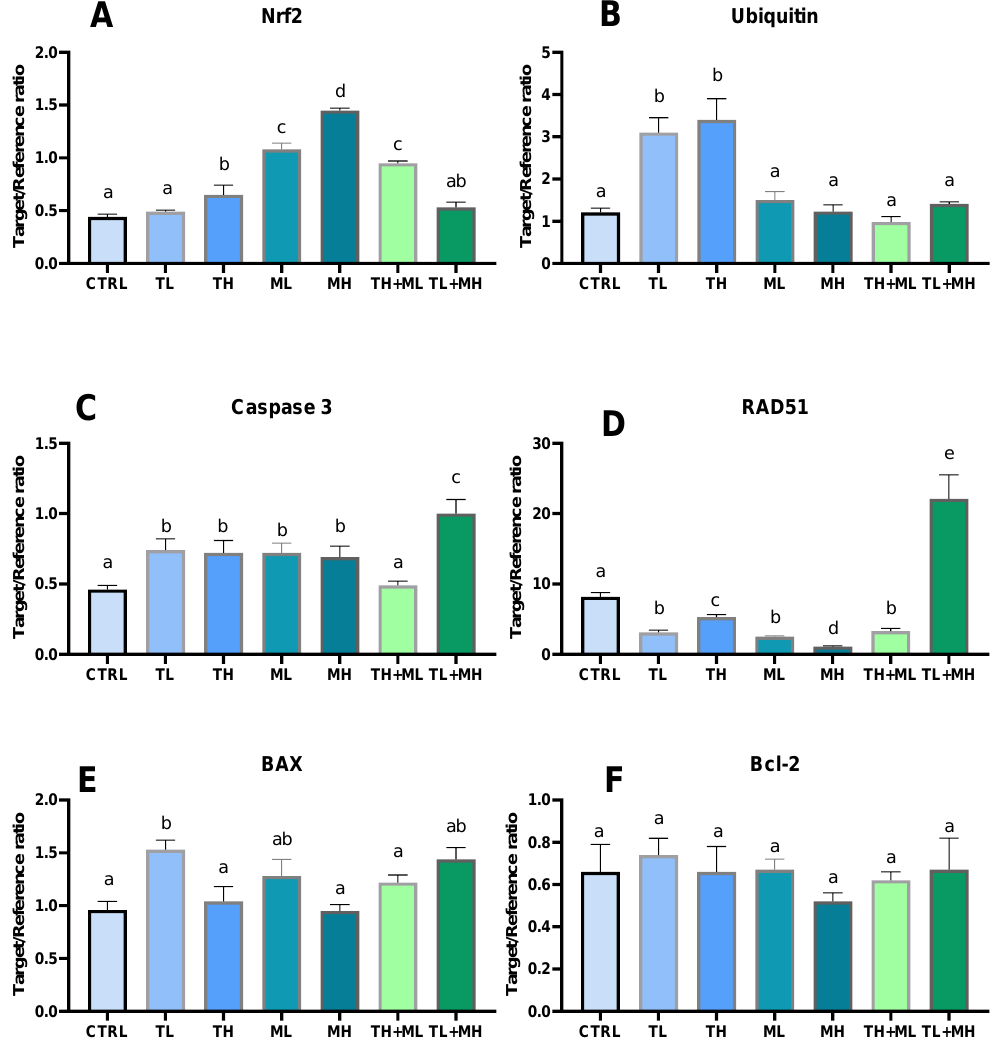
Figure 5. Effects of terbuthylazine (2 µ g L − 1 (TL) and 30 µ g L − 1 (TH)) and malathion (5 µ g L − 1 (ML) and 50 µ g L − 1 (MH)) exposures on mRNA expression of apoptotic, oxidative stress, and DNA damage and repair markers in the liver of zebrafish. ( A ) the nuclear factor erythroid 2–related factor 2, ( B ) Ubiquitin; ( C ) Caspase 3; ( D ) DNA repair protein RAD51; ( E ) B-cell lymphoma protein 2 (Bcl-2)-associated X; ( F ) B-cell lymphoma protein 2. Columns with different letters have significantly different values ( p < 0.05). The means and the standard errors of the mean are presented. N = 6.